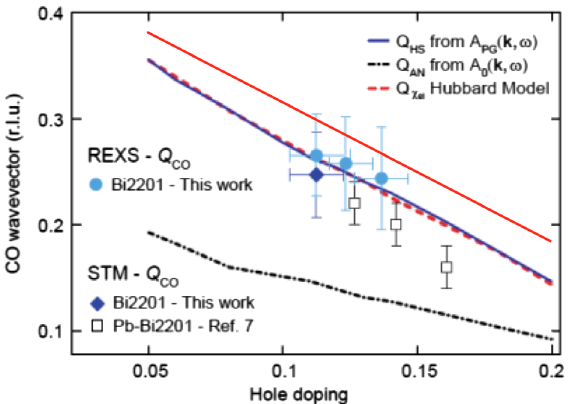
FIG. 6. A collection of data for the CDW wave vector δ (in units of 2 π ) vs hole-doping concentration on the Bi2201 system, taken from Ref. [5]. The dashed dotted line marked Q surface spanning vector at the antinode, which corresponds to Q in our notation. The solid red line is approximately 2 Q is the prediction of the Amperean pairing